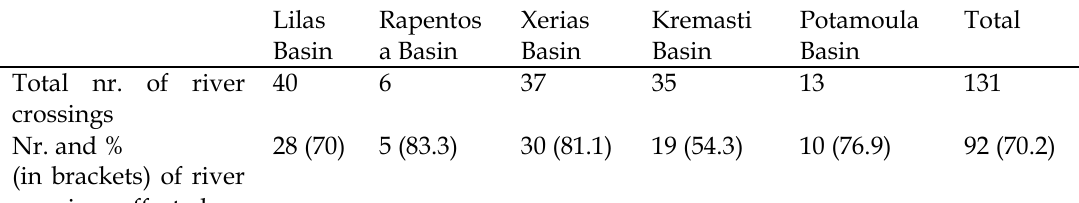
Table 3. Effects of flooding in river crossing infrastructure in the examined basins